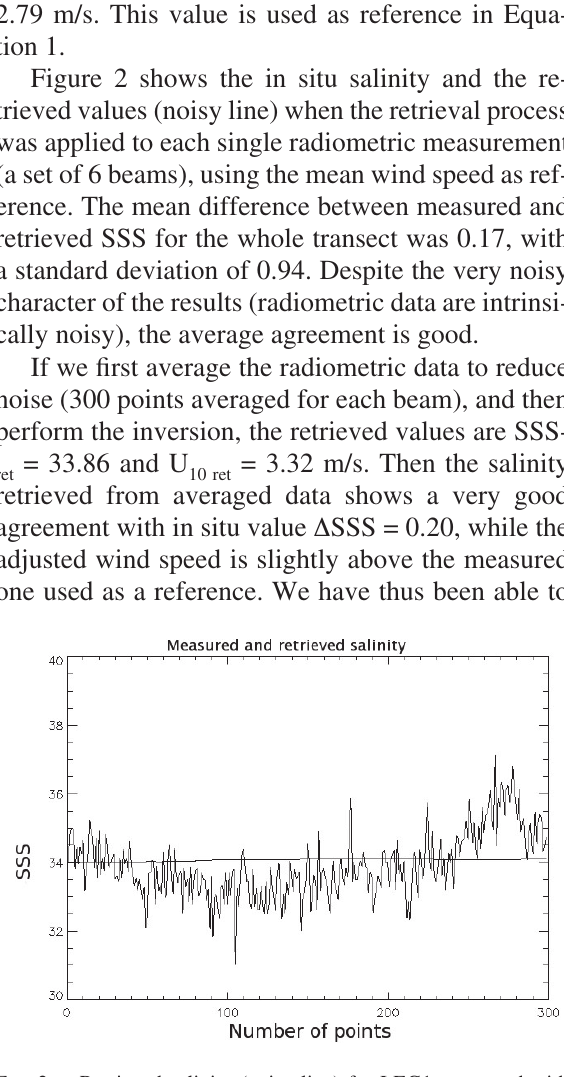
Fig . 2. – Retrieved salinity (noisy line) for LEG1 compared with measured salinity (stable